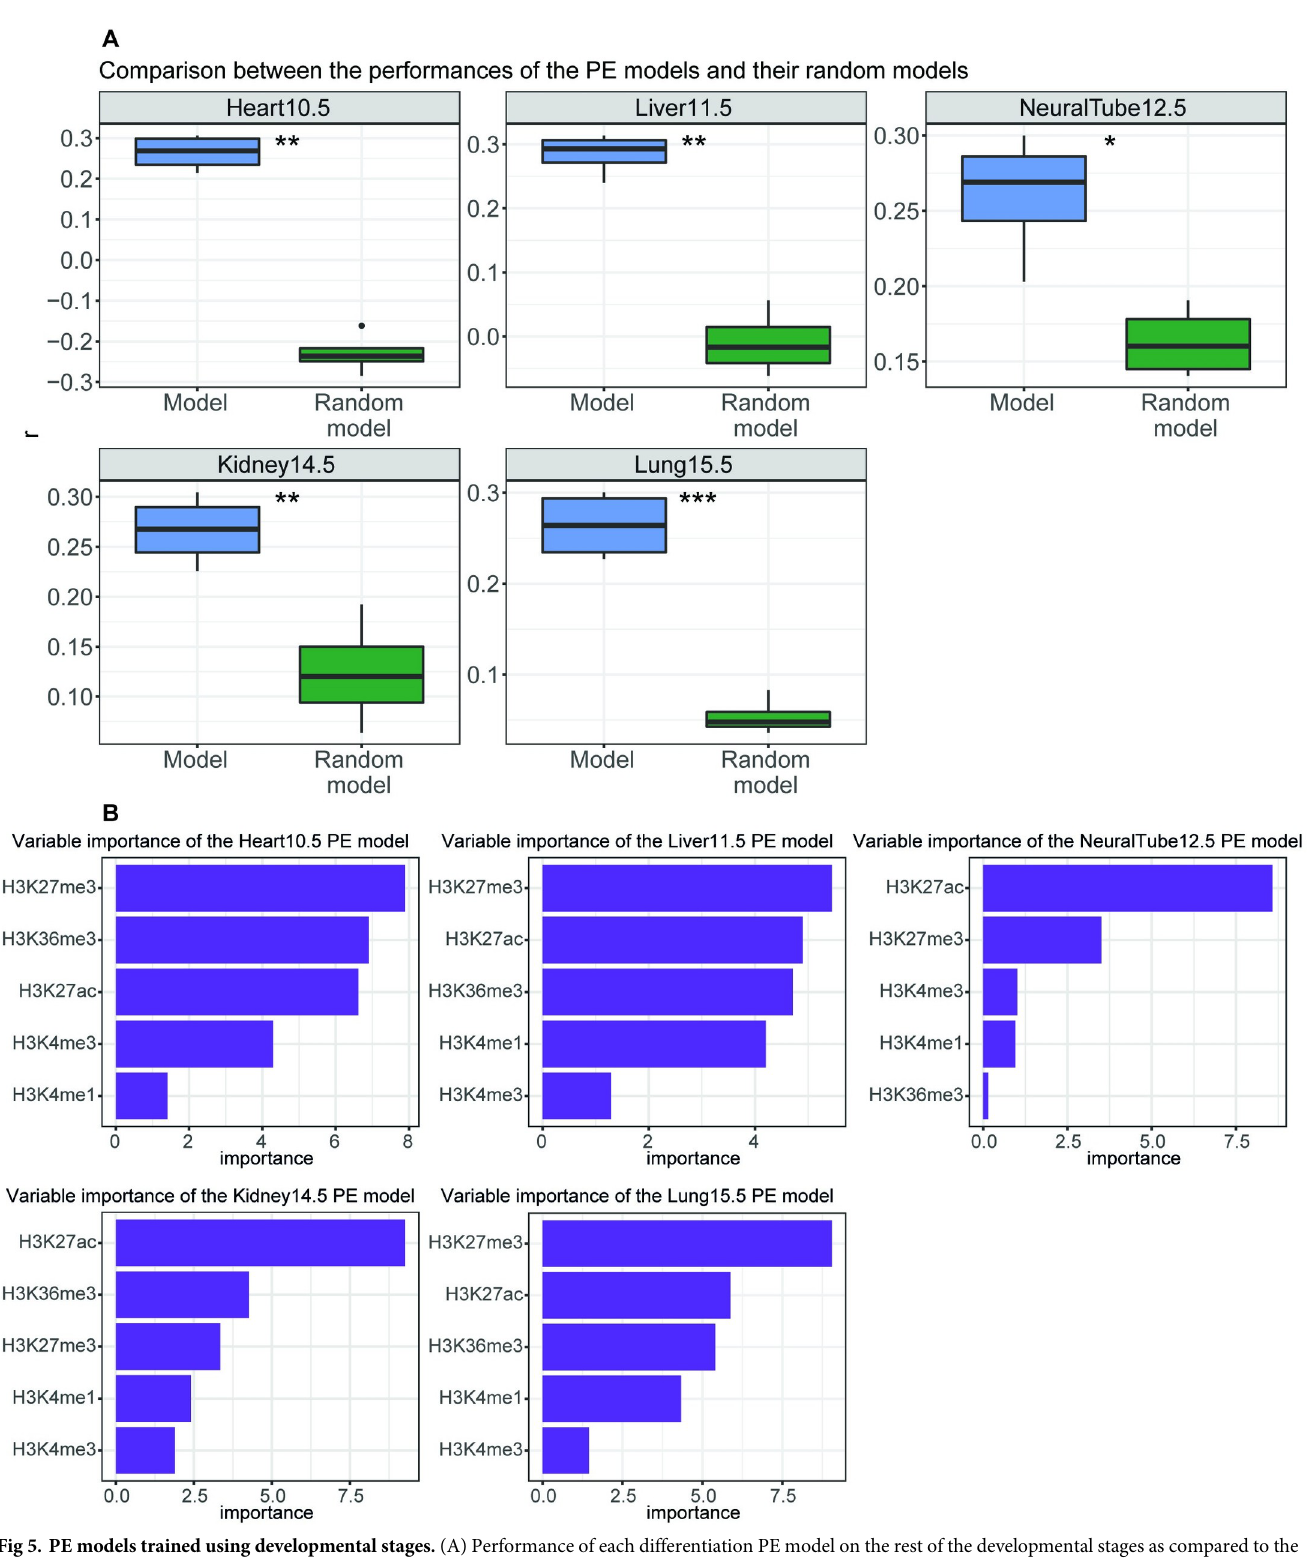
Fig 5. PE models trained using developmental stages. (A) Performance of each differentiation PE model on the rest of the developmental stages as compared to the performance over the random models. Performance is represented as Pearson’s correlation ( r ) between predicted expression and measured expression. Significance was assessed using a paired Student’s t -test of the performance of the models or of the random models paired by a differentiation test set ( ���� p < 0.0001,